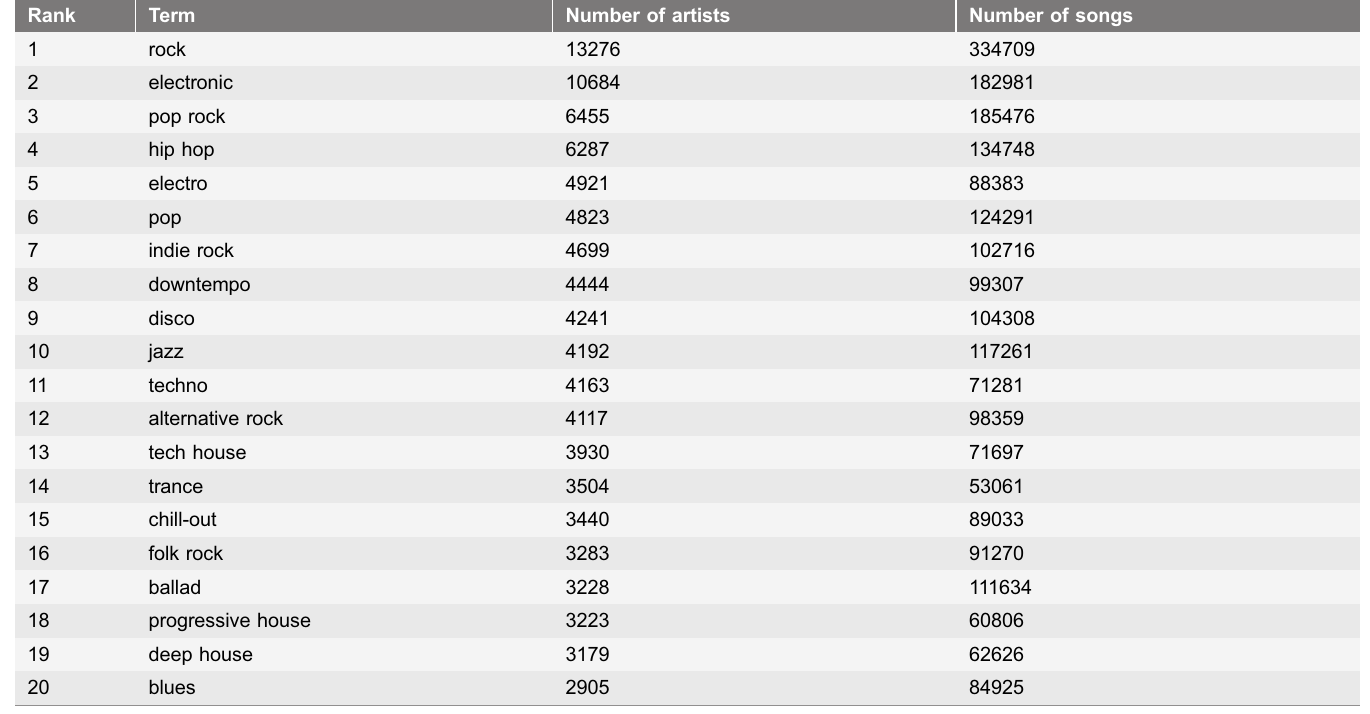
Table 1. The 20 most frequent artist_terms included in the Million Song